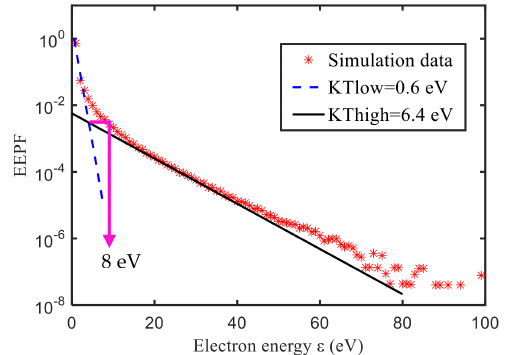
Figure 6. Diagram of EEPF as a function of electron